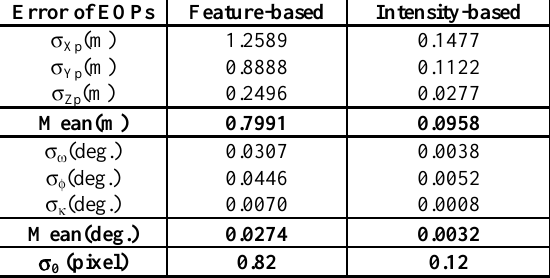
Table 2. Errors of estimated EOPs of aerial image Error of EOPs Feature-based Intensity-based